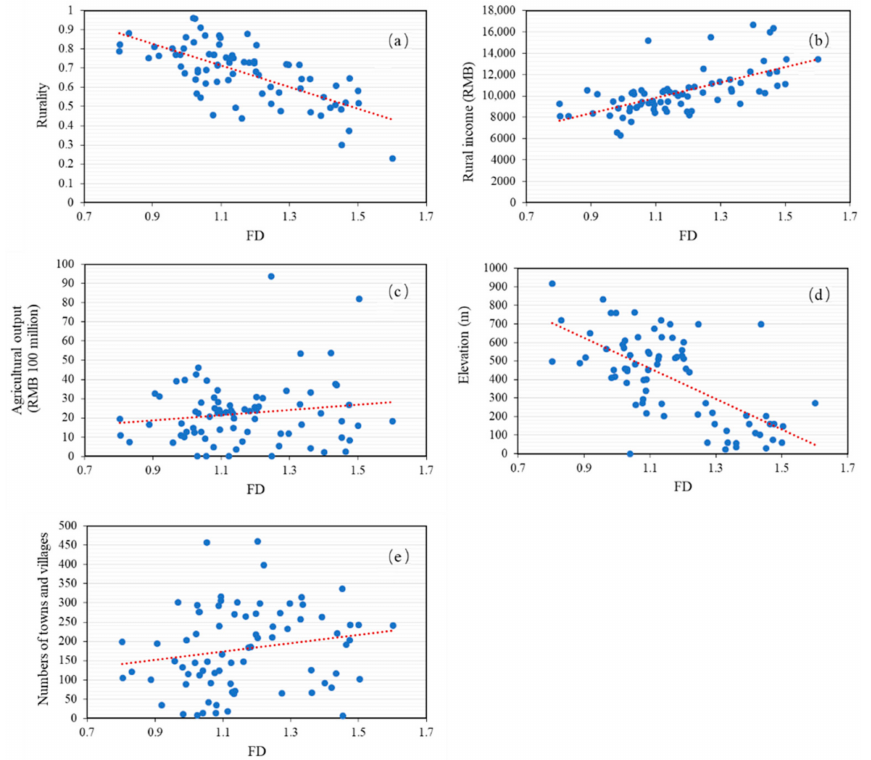
Figure 6. Hypothesized factors in the SEM model, including rurality ( a ), rural income ( b ), agri- cultural output ( c ), elevation ( d ) and the numbers of towns and villages ( e ). RMB: Renminbi; FD: Fractal